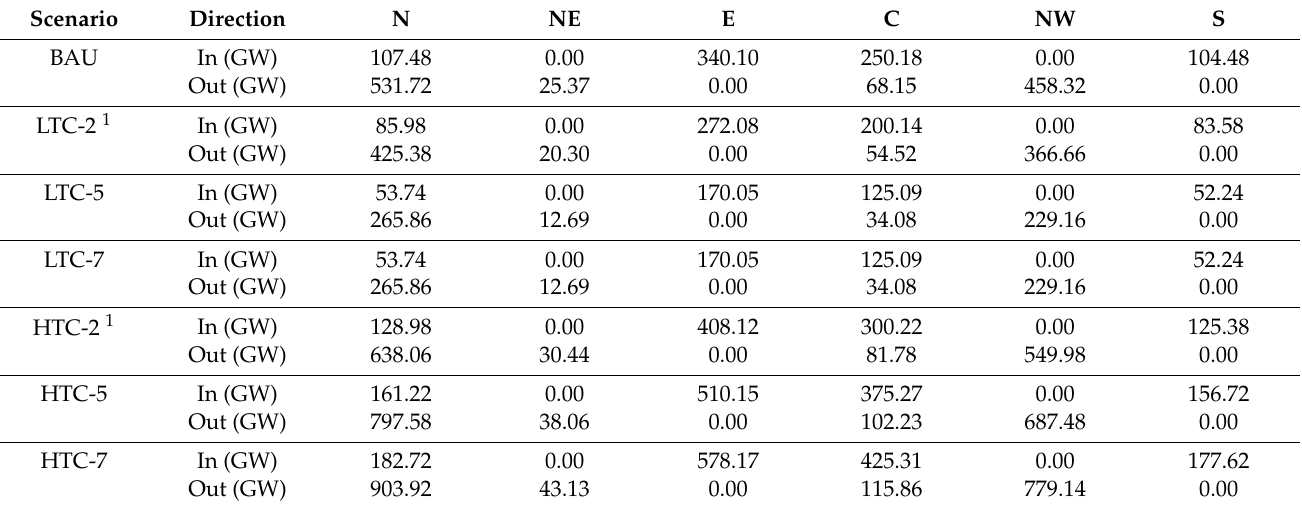
Table A3. Regional transmission capacity of seven scenarios in 2040.